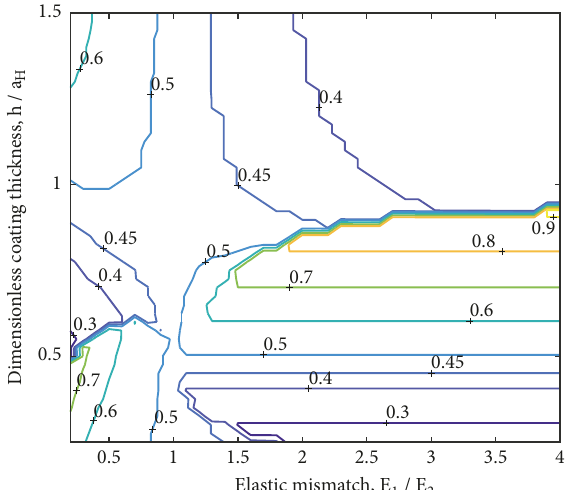
Figure 15: Iso-contours of dimensionless depth of the maximum von Mises equivalent stress ℎ ( max ) 𝑉𝑀 /𝑎 𝐻 .